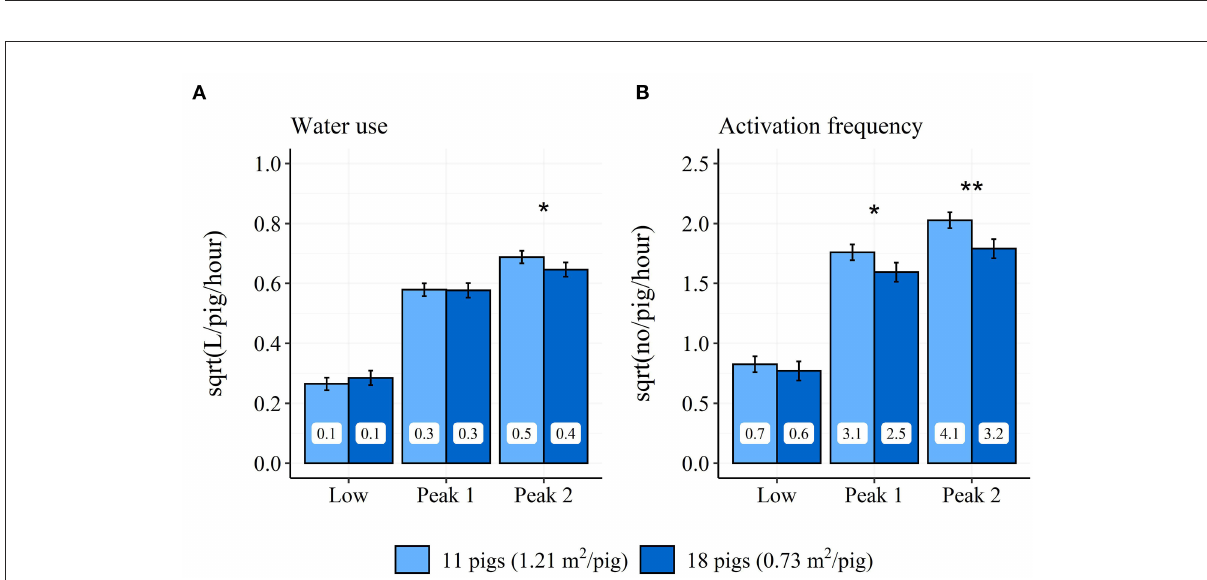
FIGURE5 Differences in model estimated average hourly water use (A) and activation frequency (B) between pens with low and high stocking density during the “Low” (18:00–05:59h), “Peak 1” (06:00–11:59h), and “Peak 2” (12:00–17:59h) time periods across the finisher period. Error-bars represent standard errors of the mean. The back-transformed model estimates are shown within each bar. * P < 0.5, ** P < 0.01 between pens with high and low stocking